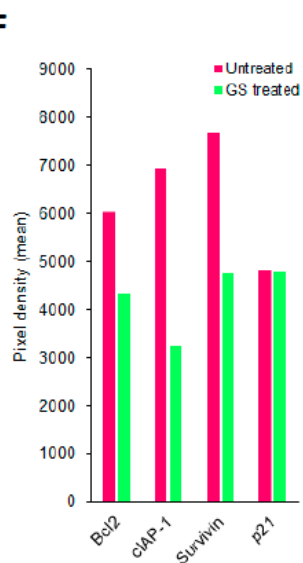
Figure 6. Biological pathways enriched by GS treatment and their validation by antibody arrays. ( A ) The top nine pathways enriched by the functional enrichment analysis of the dysregulated proteins. ( B , D ) Representative images of the antibody arrays showing expression levels of various proteins: ( B ) Human apoptosis signaling array C1 (RayBiotech) and ( D ) Proteome profiler Human apoptosis array (R&D Systems). ( C , E , F ) Quantitative profiles of protein expression levels on antibody arrays by densitometry analysis. Values are represented as mean ± SD ( n = 6). Images are representative of three independent experiments. RS denotes reference spots. The arrays are spotted with the antibodies in duplicates. The array coordinate maps with the corresponding antibody / protein names are as illustrated in Supplementary Figures S3 and S4.